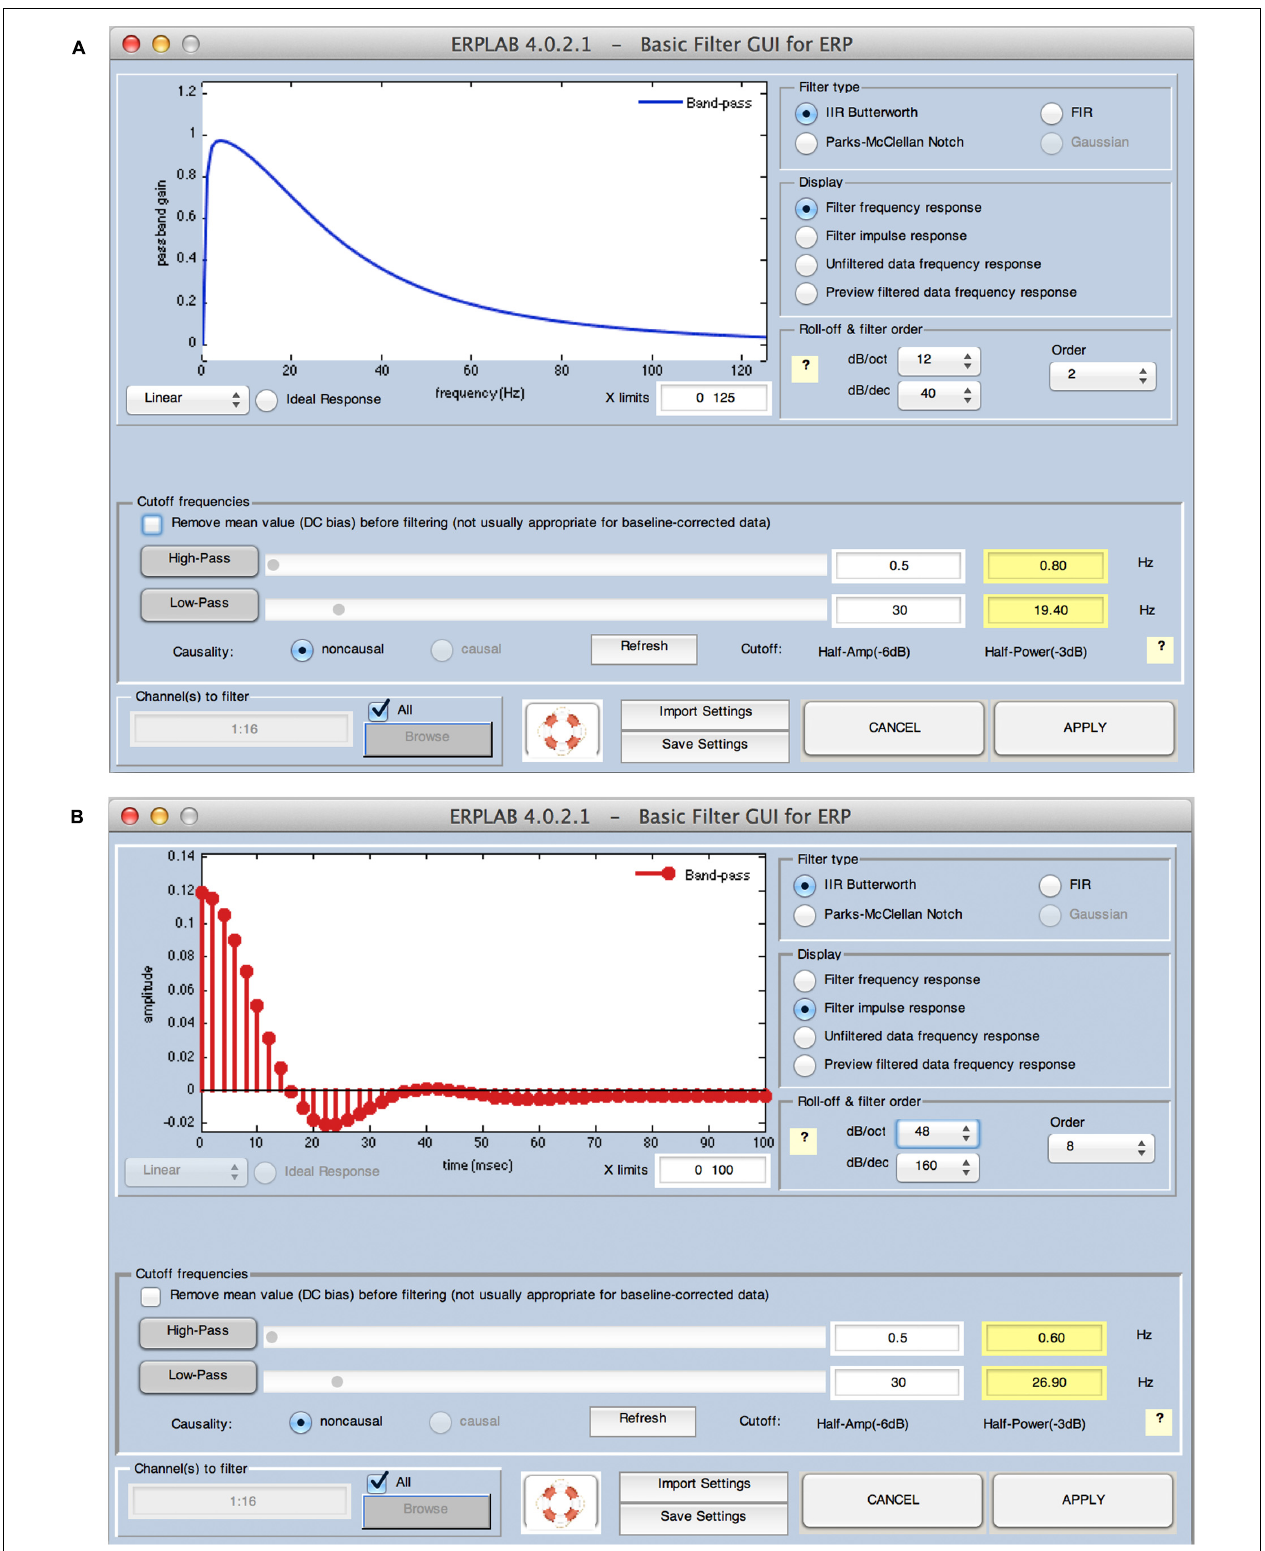
FIGURE 2 | ERPLAB’s filtering interface, which can show the frequency response function (A) or the impulse response function (B) of the currently specified filter.